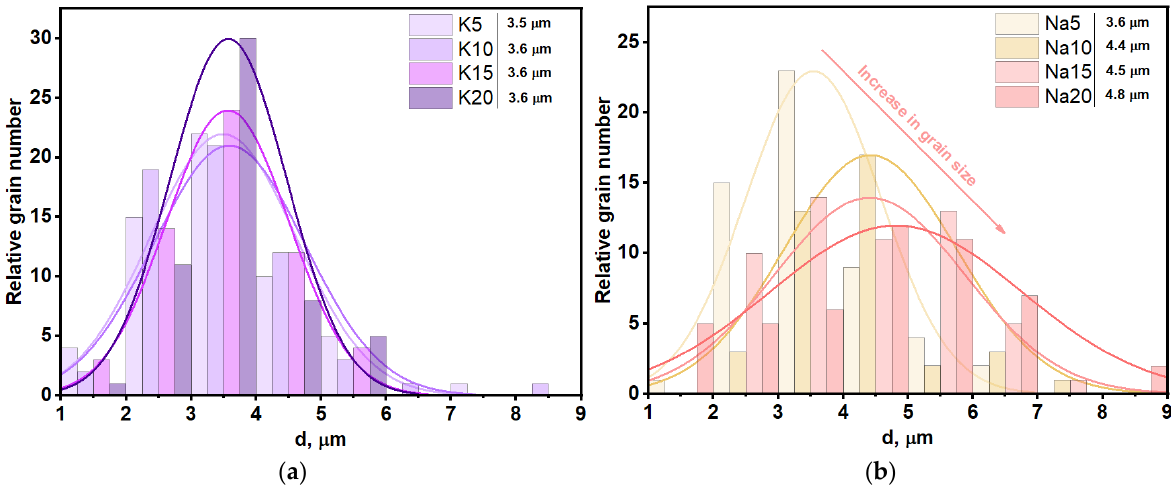
Figure 6. Grain size distribution in: ( a ) K-containing, ( b ) Na-containing ceramic samples. The grain sizes were also calculated from the SEM images using ImageJ software. It is worth noting in the linescans, that in the Na-containing samples, grains tended to grow with an increase in the amount of sodium, but not excessively (up to 33%). Nonetheless, this effect was not observed for potassium-containing samples, e.g., the difference be- tween the average grain sizes for Mg5K and Mg20K was less than 1%. SEM images of the sample surface are presented at Figures 7 and S3. ( a )